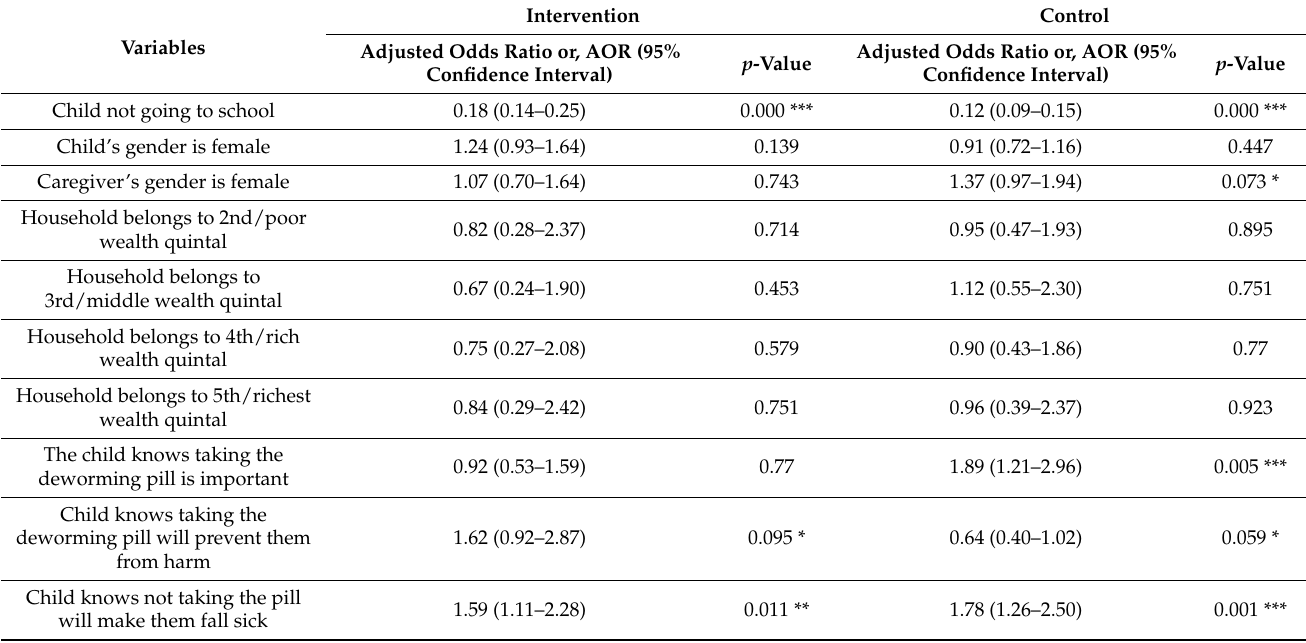
Table 5. Factors associated with deworming coverage of the